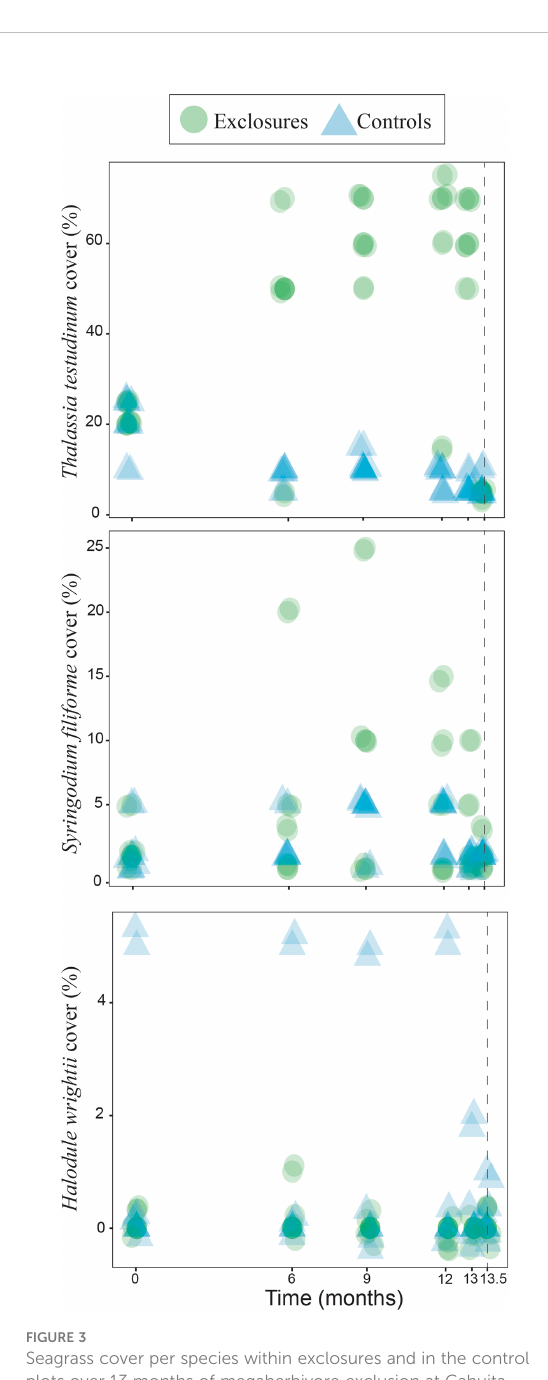
FIGURE 4 Seagrass above and below ground biomass, density, leaf area and Thalassia testudinum leaf length and width within controls and exclosures at the start and end of 13 months of megaherbivore exclusion at Cahuita, southern Caribbean coast of Costa